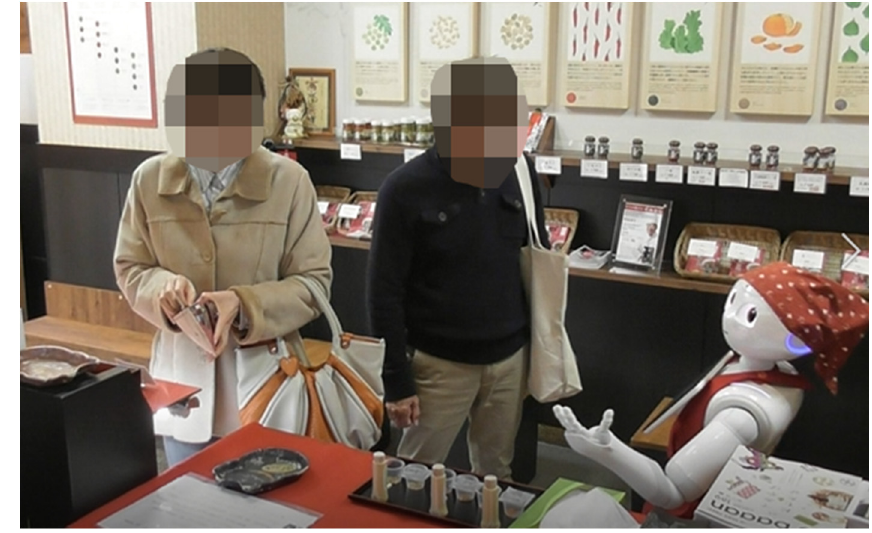
Figure 8. Robot’s movement when suggesting to taste a sample.